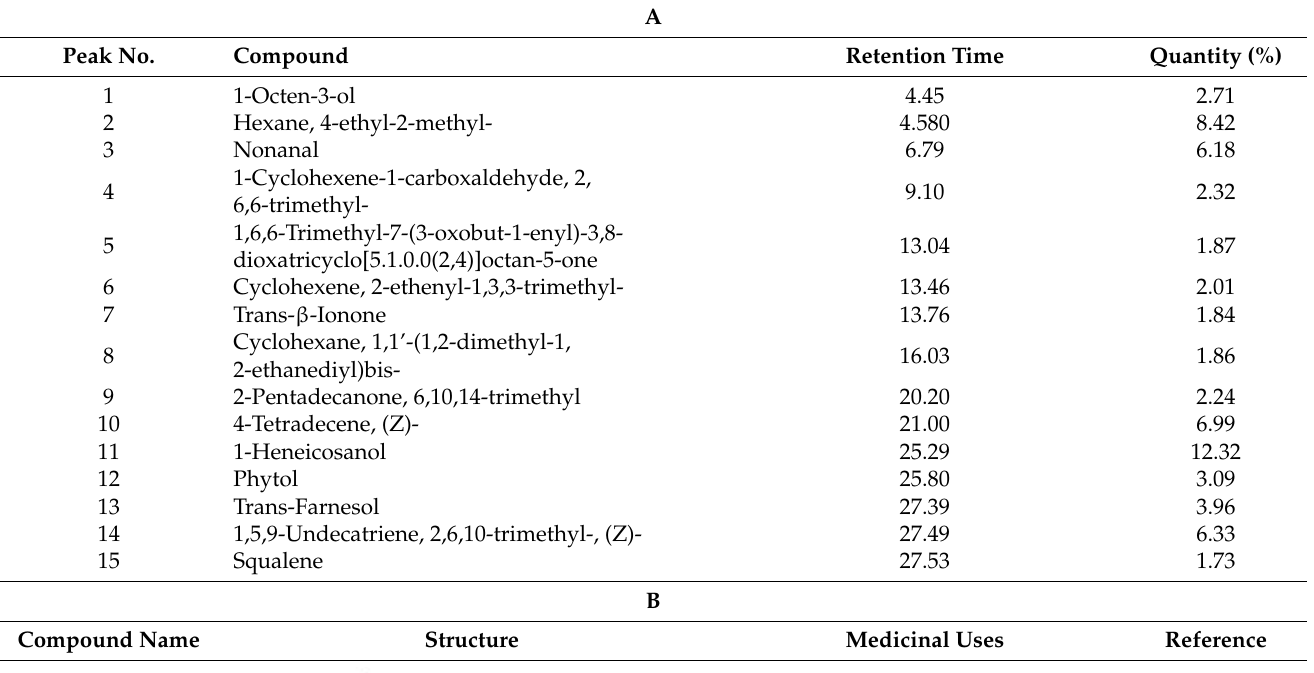
Table 1. A. Compounds identified from methanol extract of C. pepo leaf. B. Structural and pharmaco- logical potentials of major bioactive compounds identified from methanol extract of C. pepo